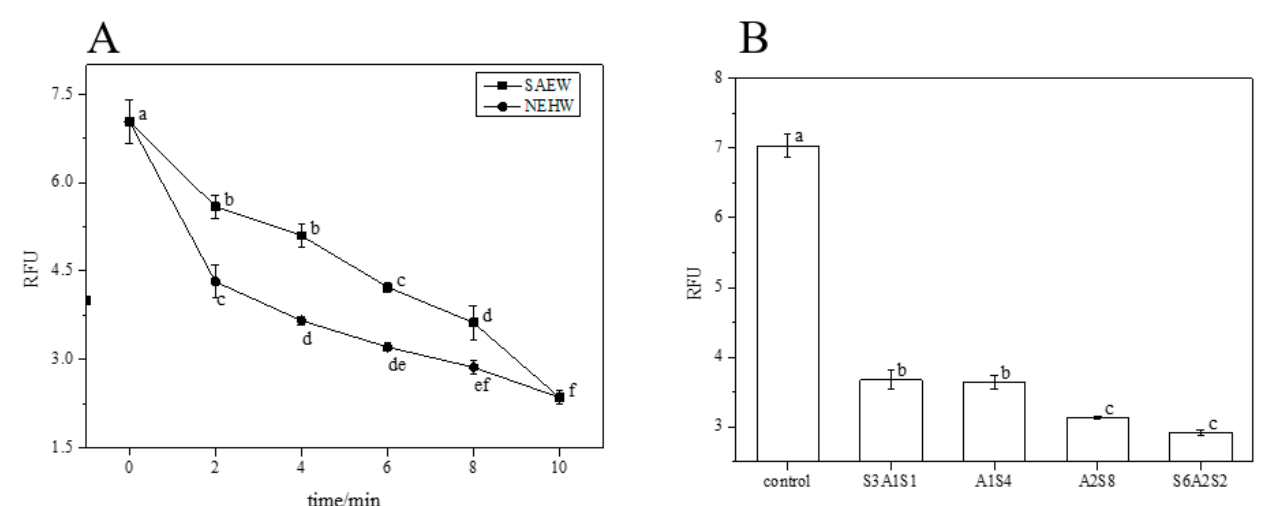
Figure 15. The RFU of residual eRNA content in each treatment group. ( A ) is the RFU of residual eRNA after SAEW and NEHW treatment. ( B ) is the RFU of residual eDNA after AEW and ALEW treatment. The different letters indicate significant differences ( p < 0.05). Data were expressed by mean measurements ± standard deviation (SD) and all treatments and determinations were performed in triplicate. Table 3. The residual eRNA content in the biofilm of Listeria monocytogenes in each treatment. 0 min